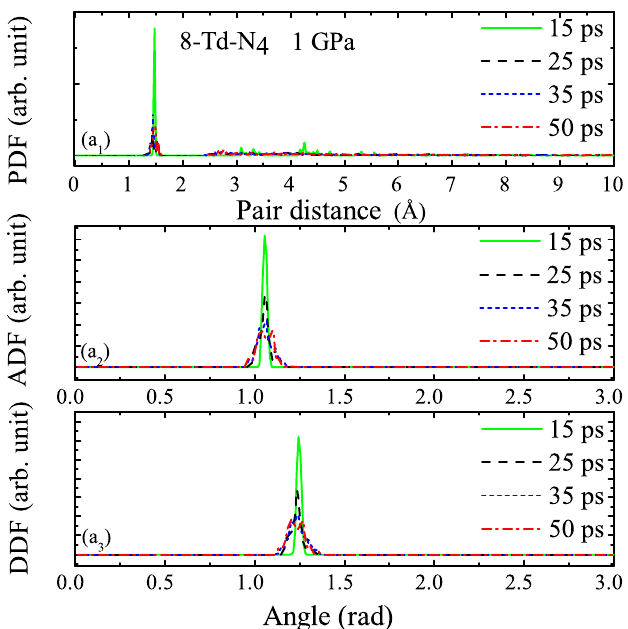
Figure 12. ( a 1 – a 3 ) Pair distribution functions at 15, 25, 35, and 50 ps under 1 GPa in the MD simulations.